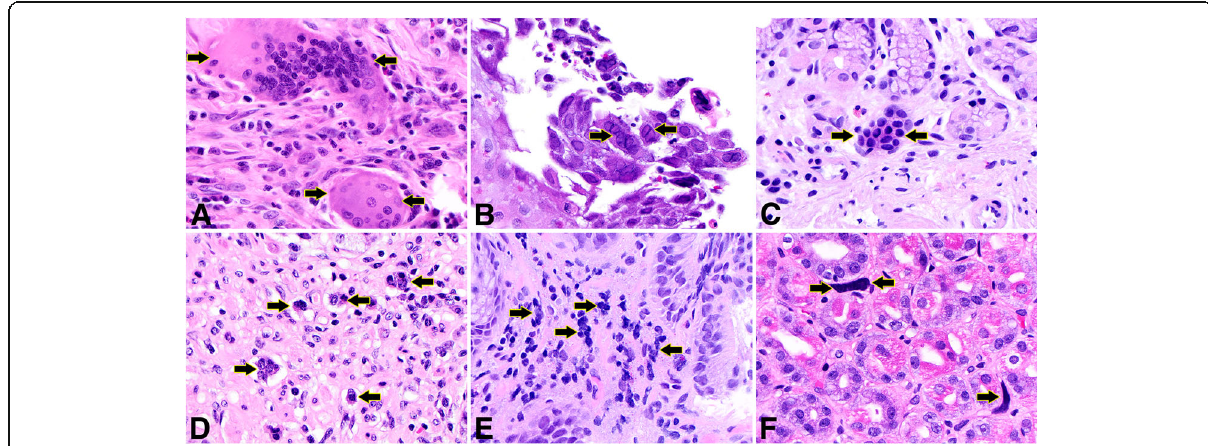
Fig. 3 Other multinucleated cells and mimics in the gastroesophageal mucosa. ( a ) Foreign-body-type multinucleated histiocyte, stomach. ( b ) Herpes Simplex viral cytopathic effect, esophagus. ( c ) Tangentially sectioned pit epithelium, stomach. ( d ) Tight clusters of neuroendocrine cells (neuroendocrine nests post chemoradiation therapy), gastroesophageal junction. ( e ) Cluster of crushed inflammatory cells, gastroesophageal junction. ( f ) Benign megakaryocytes in the setting of myelofibrosis, stomach. Hematoxylin and eosin stain, original magnification